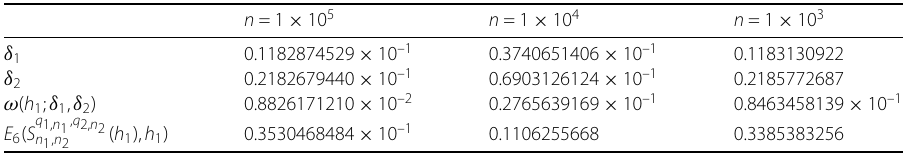
Table 6 The approximation error of S